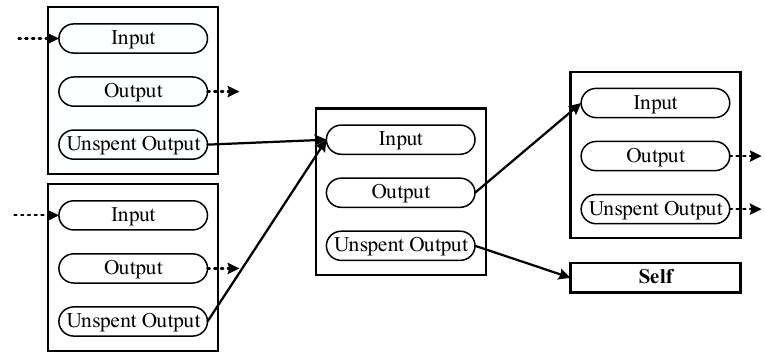
Figure 5. The unspent transaction output model.